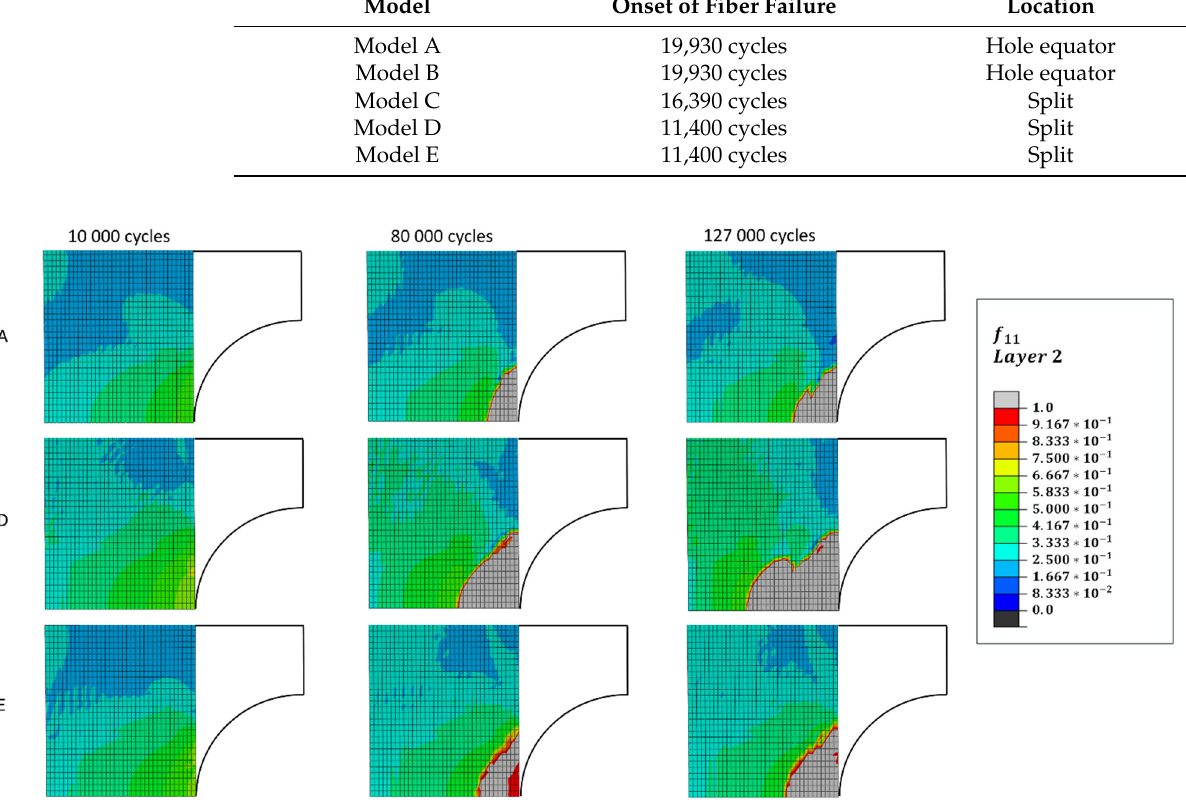
Figure 26. Exposure factor in the fiber direction of the bottom hoop layer at 80,000 cycles. Only one side of the shear crack is shown as damage developed there.